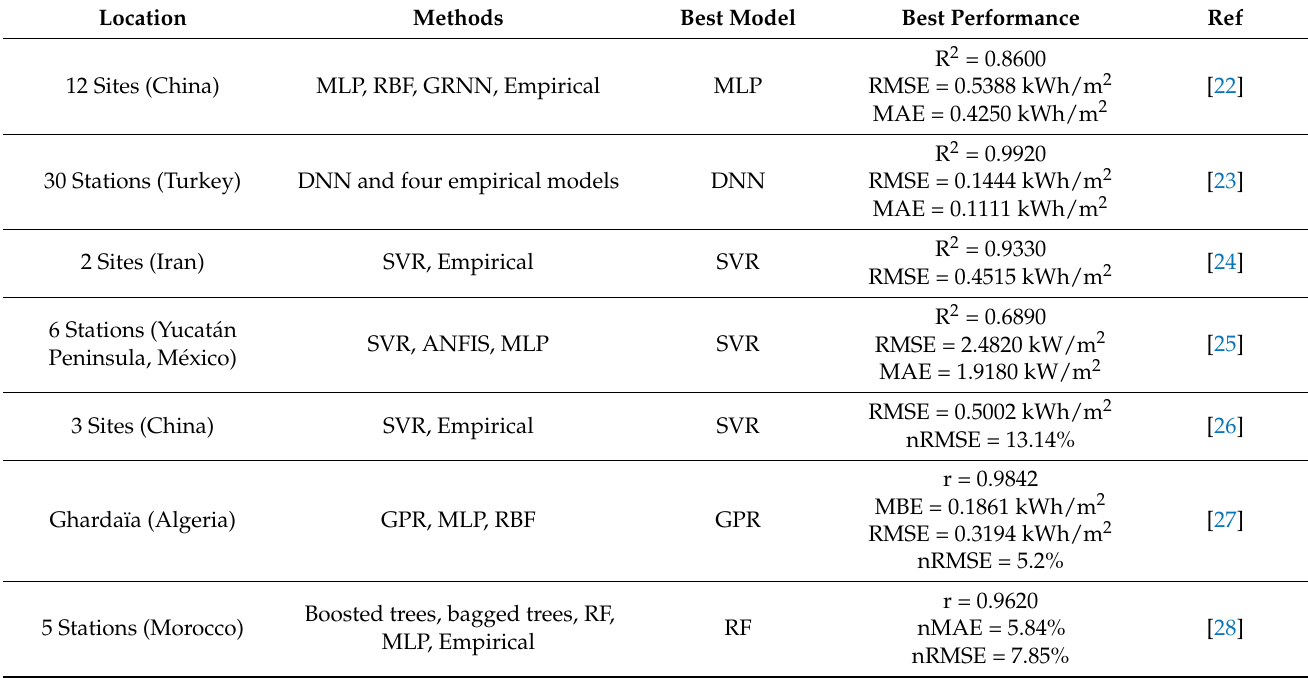
Table 1. List of some studies related to the global solar radiation estimation in the literature using ML models. Location Methods Best